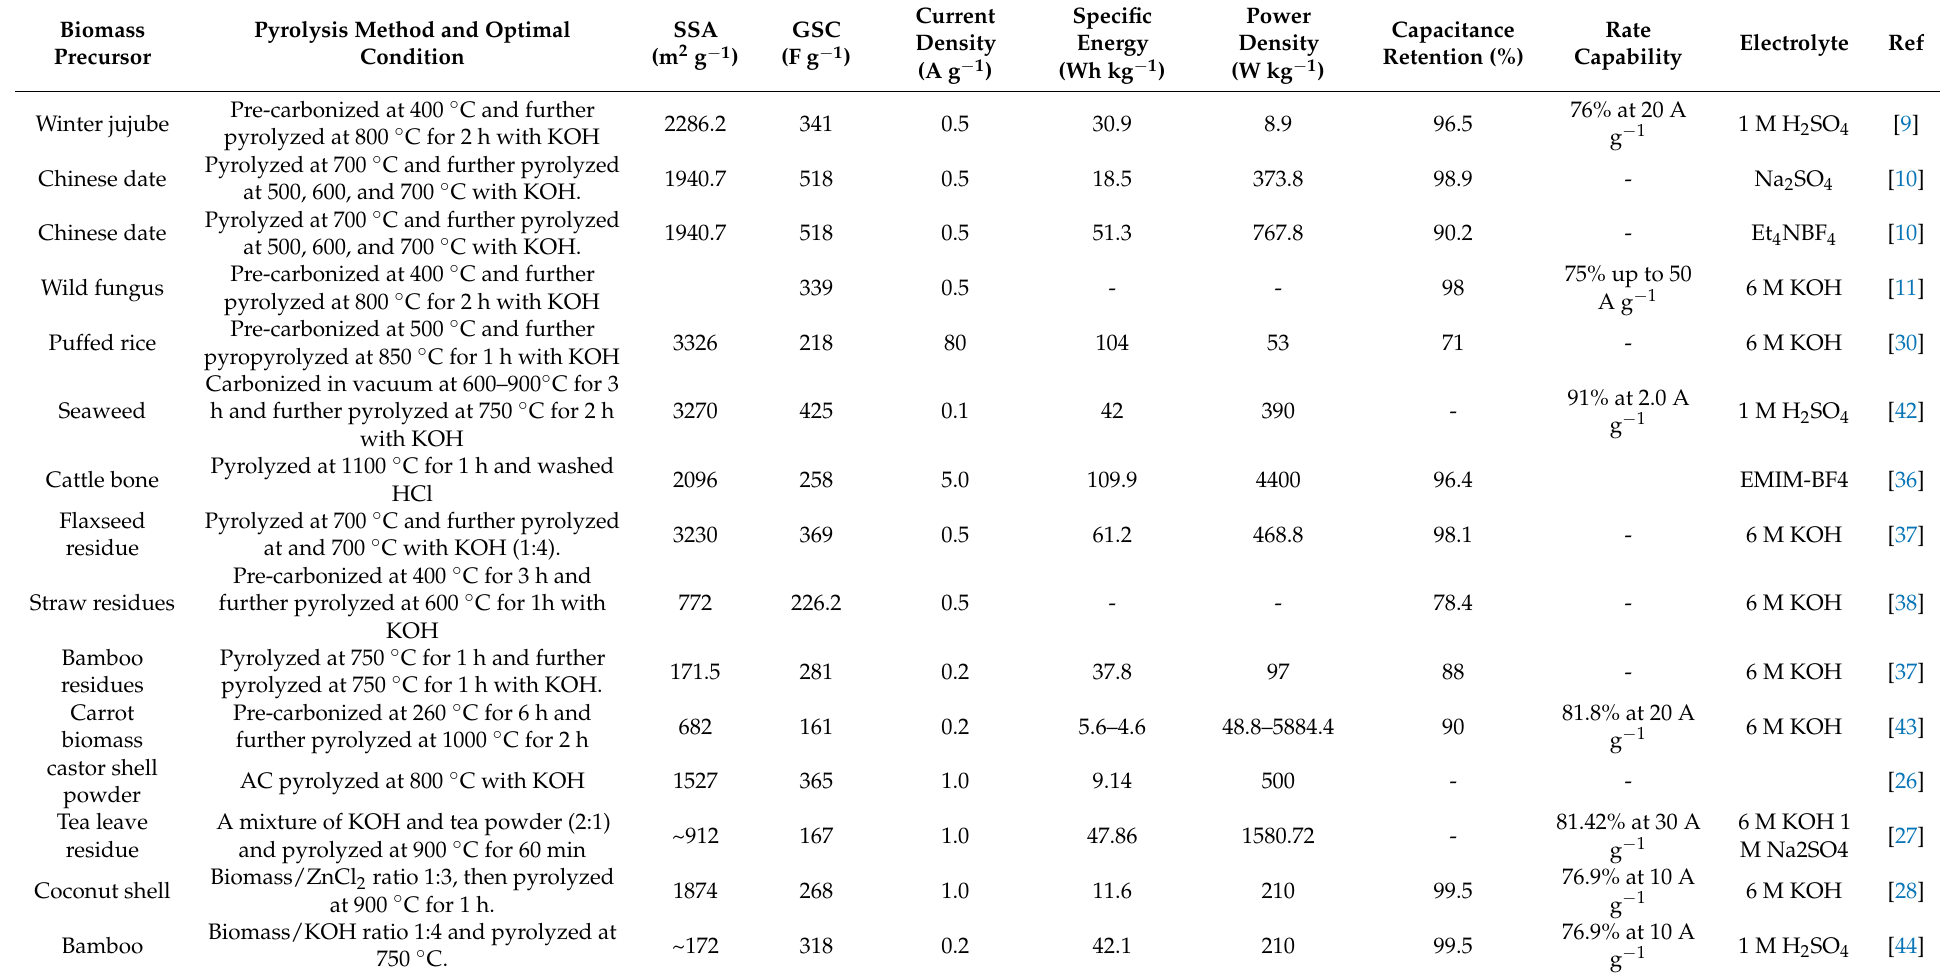
Table 1. Electrochemical properties of biomass-based electrodes for supercapacitors (SCs) under different